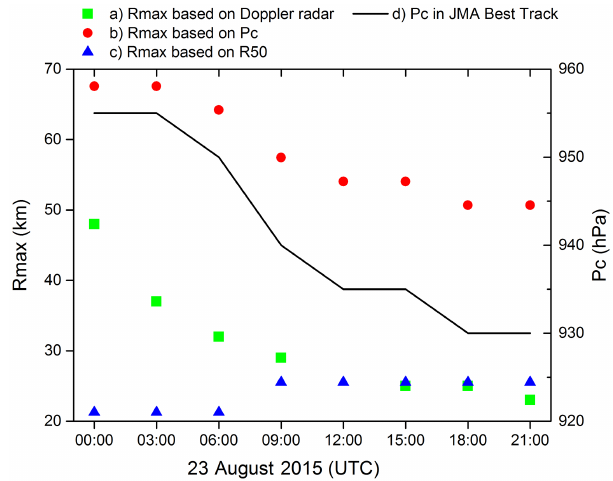
Figure 12. Estimated maximum wind radius and central pressures of the 2015 Typhoon Goni during its transit near Ishigaki-jima, (a) R max detected by a Doppler radar operated by JMA, (b) R max estimated from the relationship R max = 0.676 P c − 578, (c) R max from R max = 0.23 R 50 , and (d) Pc in the JMA best track